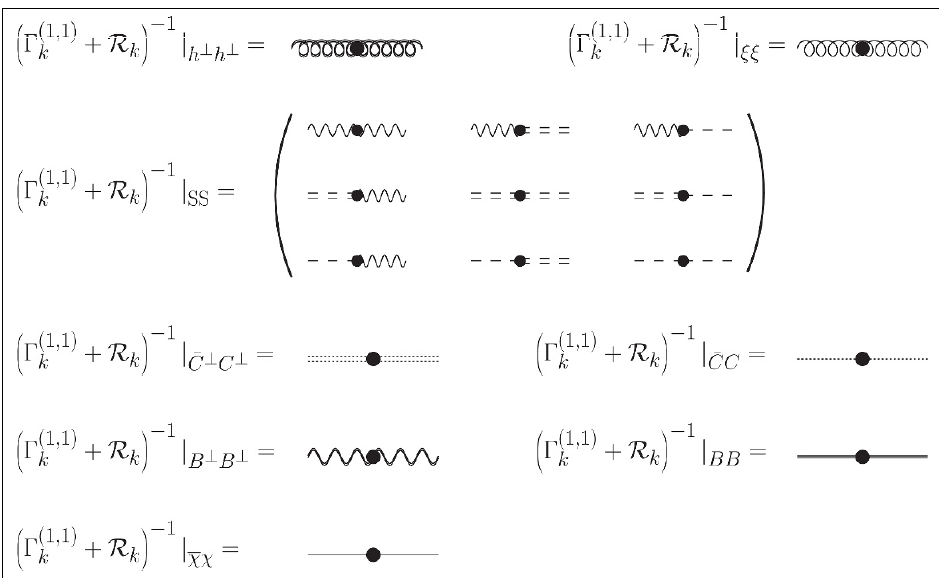
Figure 1 . The Feynman diagrams of